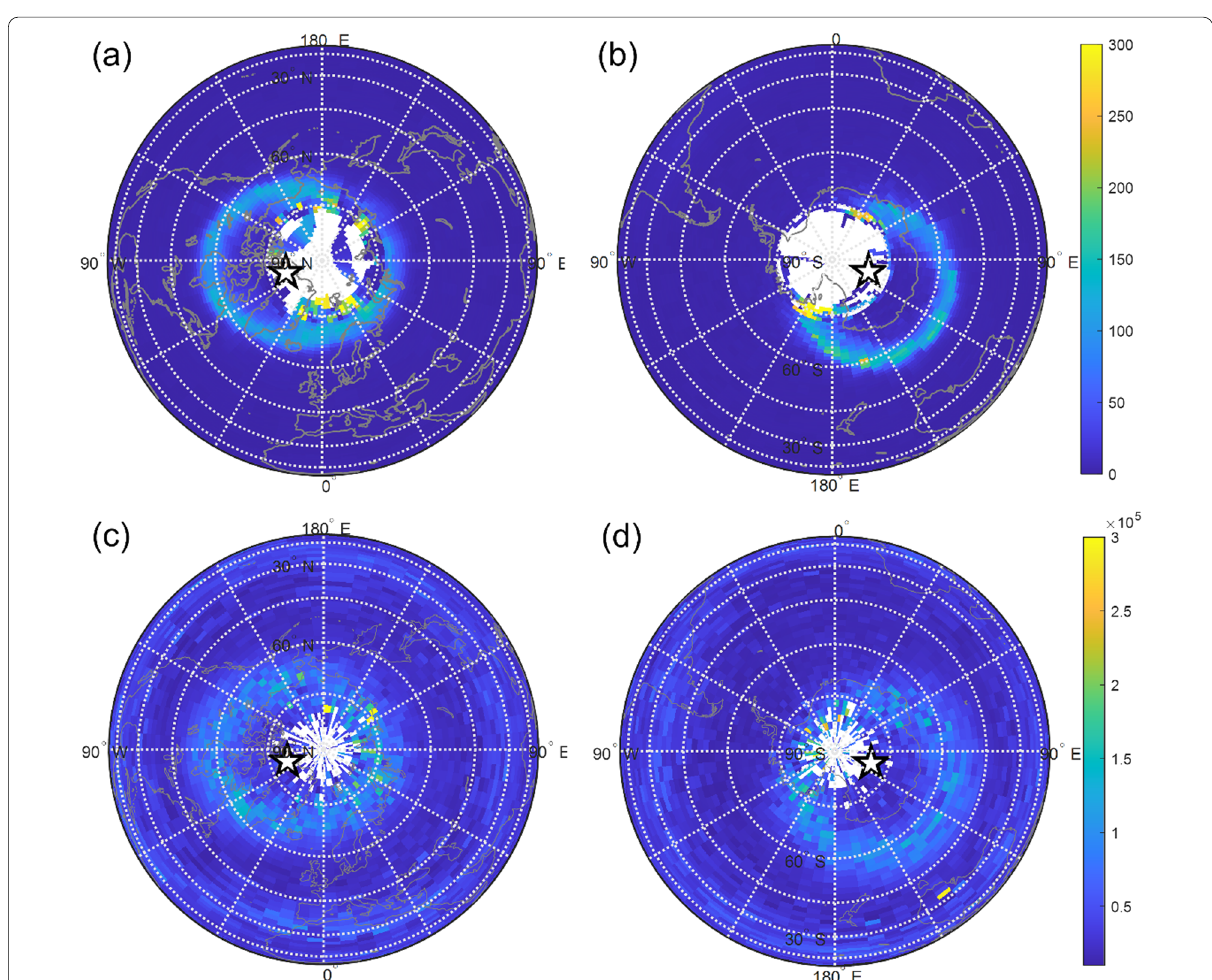
Fig. 7 The annual median TIP radiance (top plots) vs. GOX peak density in the E layer (lower plots) for the northern and southern hemispheres (left and right plots) in 2007. The unit of the TIP radiance is Rayleigh; the unit of the GOX NmE is cm − 3 . Each concentric grid indicates 75, 60, 45, 30 and 15° latitude. The TIP intensities are the medians values in 5° longitude and 1° latitude grid. The white star denotes corresponding magnetic pole